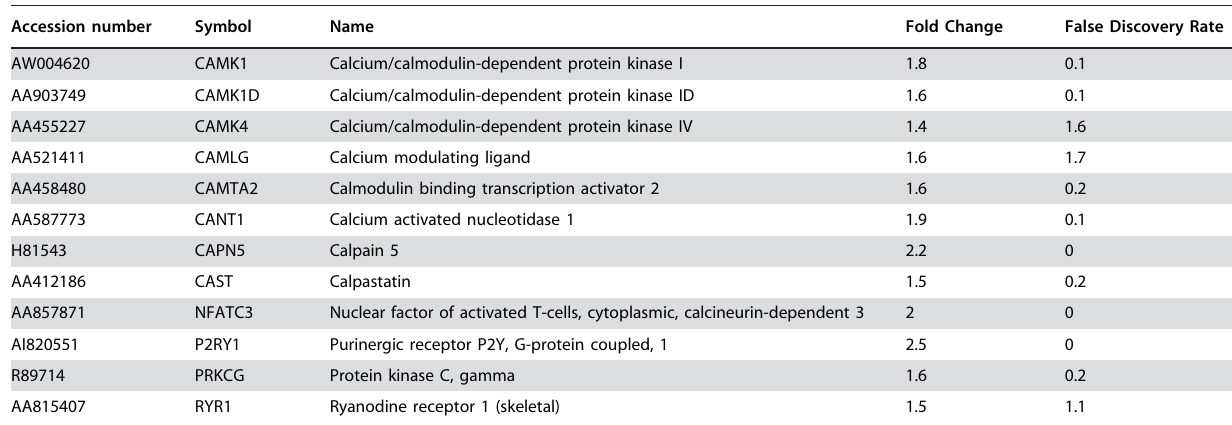
Table 3. Genes associated with calcium regulation are upregulated in NPC fibroblasts. .. ... .... ... ... .... ... ... .... ... ... .... ... ... .... ... ... .... ... ... .... ... ... .... ... ... .... ... ... .... ... ... .... ... ... .... ... ... .... ... ... .... ... ...